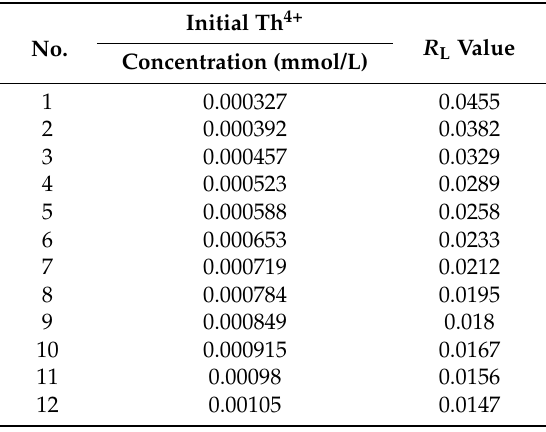
Table 1. R L values based on the Langmuir